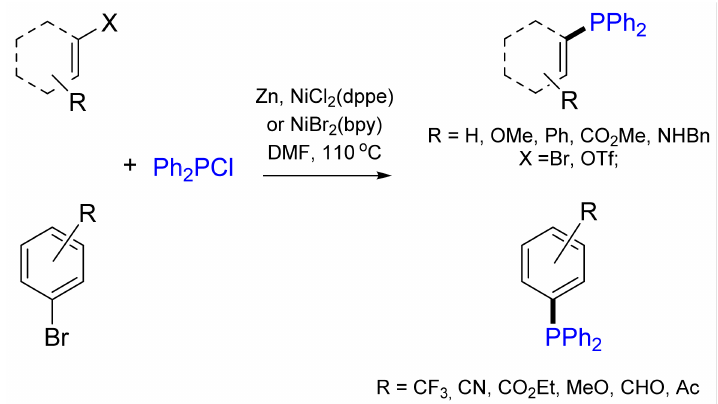
Figure 1. Nickel-catalyzed cross-coupling in the presence of zinc.